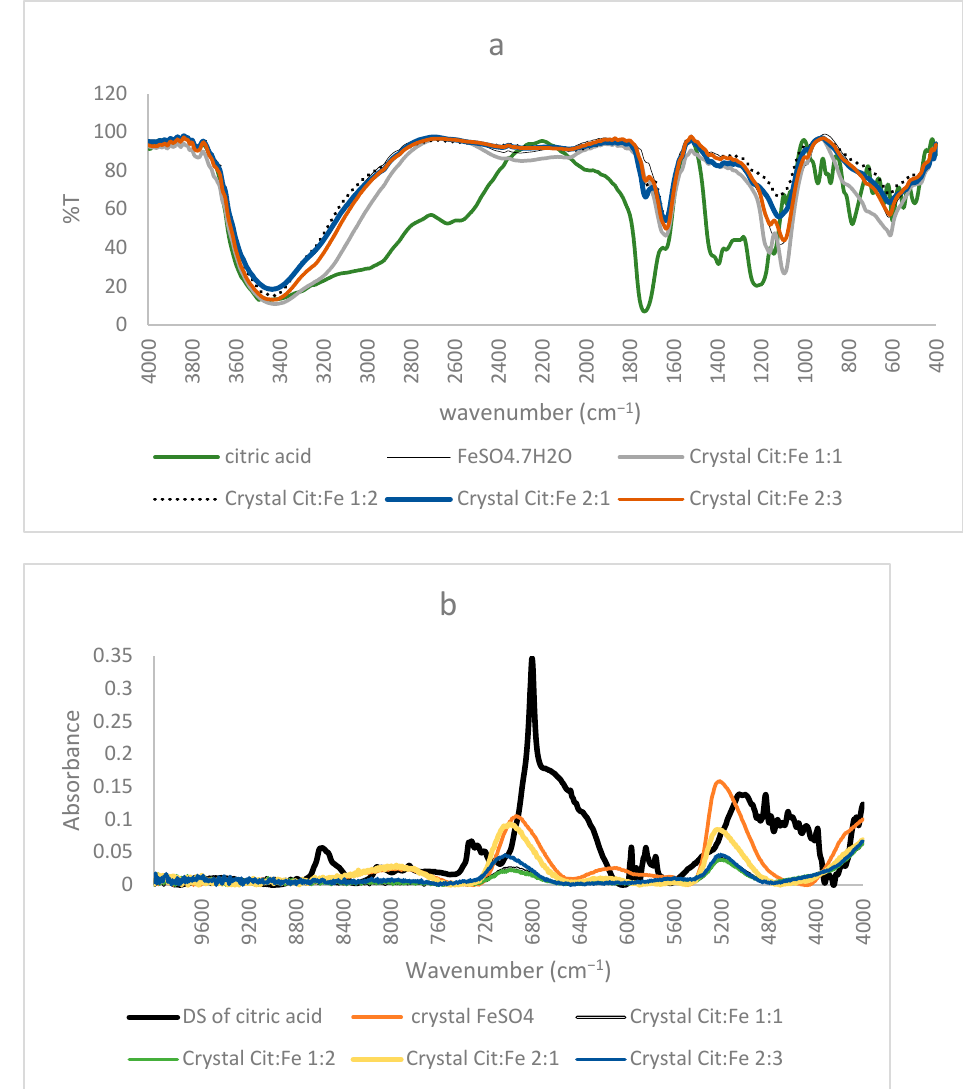
Figure 3. ( a ) FTIR, ( b ) NIR spectra of citric acid, FeSO 4 · 7H 2 O, and the obtained crystals of citric–iron at ratios 1:1, 1:2, 2:1, and 2:3 .